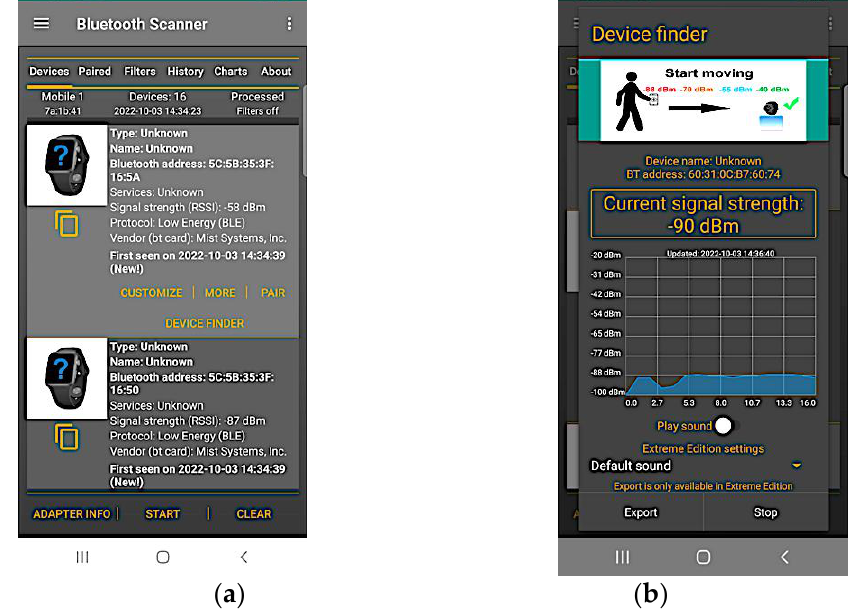
Figure 1. Data and visualizations provided by the Bluetooth Scanner app. (a) List of devices scanned by the app; (b) Bluetooth signal strength of a device gathered by the app.